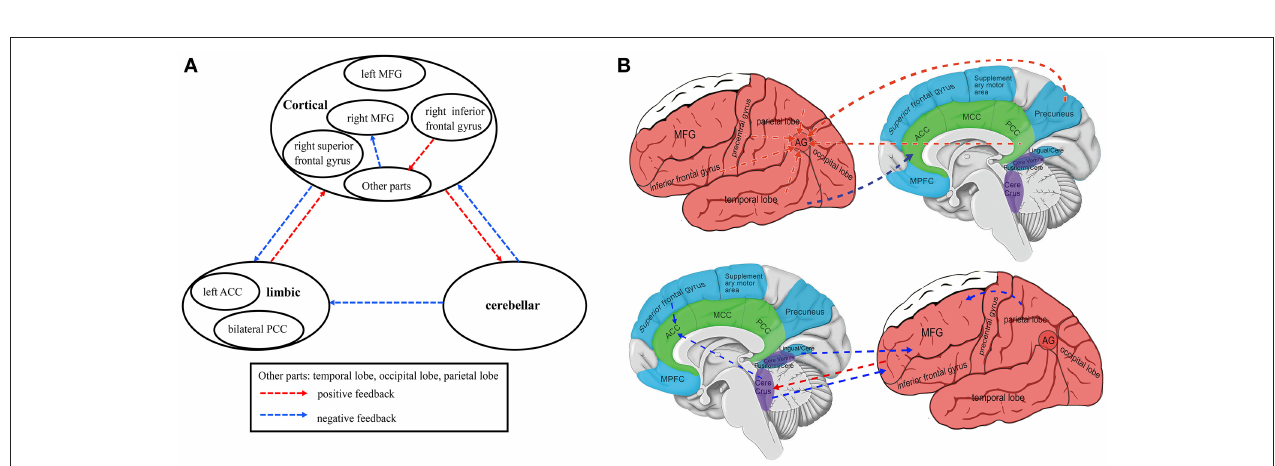
FIGURE 4 | Integrated model of voxel-wise Granger causality analyses in first-episode, drug-naive somatization disorder (Whole-Brain-to-Seed Analyses): affected causal connectivities in the cortico-limbic-cerebellar circuit (A) . Brain regions and circuitry implicated in first-episode, drug naive somatization disorder (Whole-Brain-to-Seed Analyses) (B) . MFG, Middle Frontal gyrus; MPFC, Medial Prefrontal Cortex; ACC, Anterior Cingulate Cortex; MCC, Middle Cingulate Cortex; PCC, Posterior Cingulate Cortex; AG, Angular Gyrus; Cere Crus, Cerebellum Crus; Cere Vermis, Cerebellum Vermis; Lingual/Cere, Lingual Gyrus/Cerebellum Vermis; Fusiform/Cere, Fusiform Gyrus/Cerebellum. Lateral cortical regions are shown in red, medial cortical regions in blue, subcortical regions in green, and cerebellum regions in purple. The functional pathways in (A,B) are indicated with red dotted arrows (positive feedback) and blue dotted arrows (negative